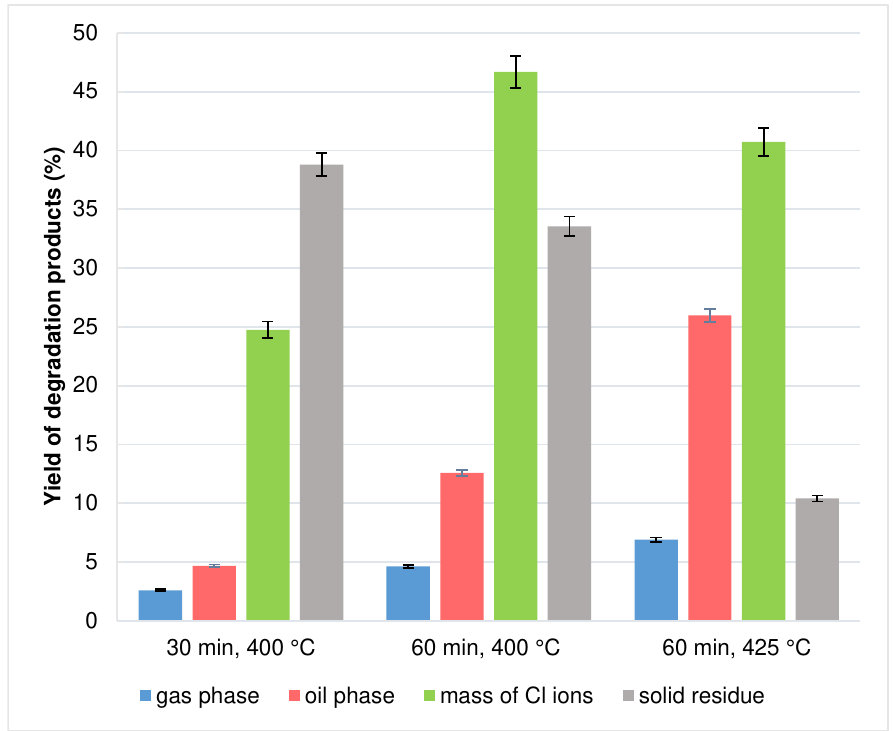
Figure 2. Yield of generated products after degradation of colorless PVC waste in SCW. Error bars in the figure indicate the standard deviation among the duplicate measurements.